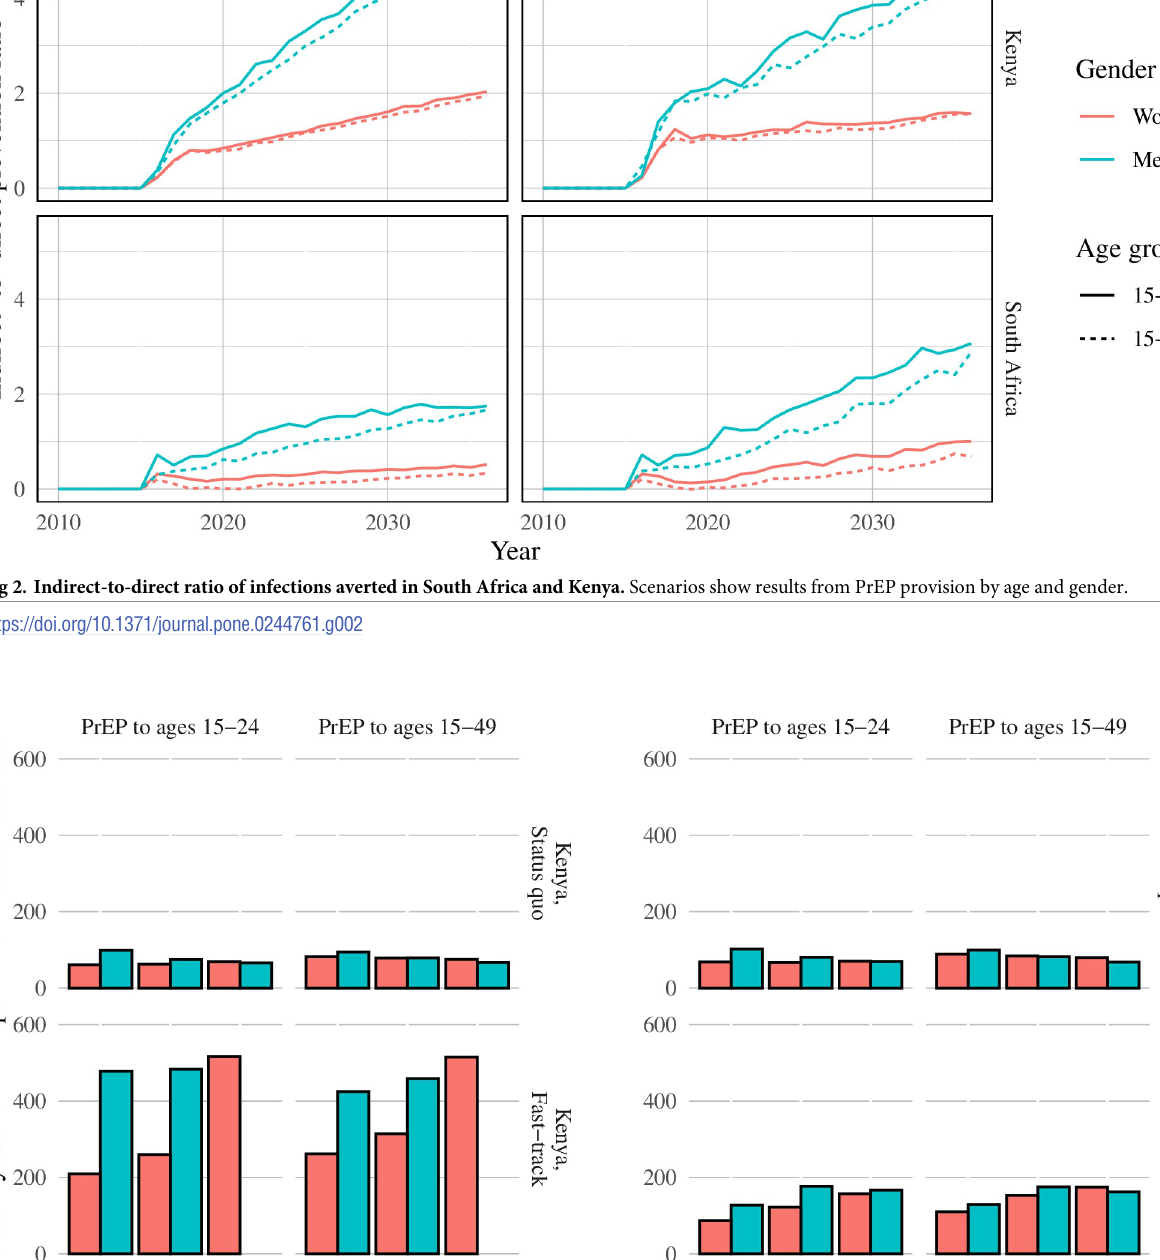
PLOS ONE | https://doi.org/10.1371/journal.pone.0244761 December31,